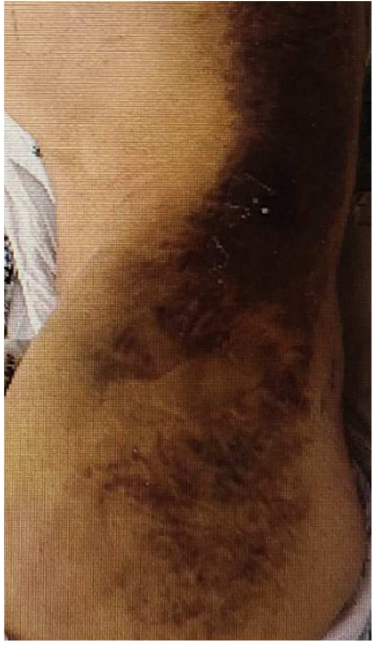
Figure 4. On physical examination, the left flank and left hip showing ecchymosis.